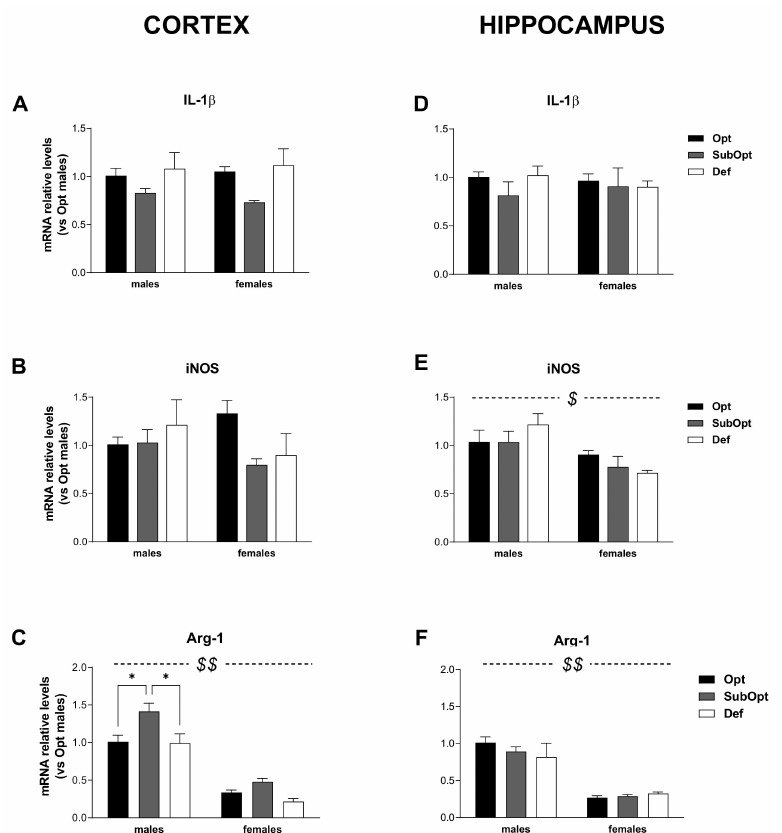
Figure 4. Effects of different Se supply on the level of IL-1 β , iNOS, and Arg-1 mRNA in the offspring’s cortex and hippocampus, evaluated by real-time PCR. The relative expression level of each mRNA was calculated using the 2 − ∆∆ Ct method, normalized to β -actin, and relative to the control group (i.e., male rats of the Opt Se dietary group). Each bar represents the mean ± SEM ( n = 5M, 5F). Cortex ( A – C ) $$ p < 0.0001 females vs. males (Arg-1: p = 0.001 for Se Opt females vs. Se Opt males; p < 0.0001 for either Se SubOpt or Se Def females vs. Se SubOpt or Se Def males, Tukey’s post hoc test). * p < 0.05. Hippocampus ( D – F ) $ p < 0.005 and $$ p < 0.0001 for females vs. males (iNOS: p < 0.05 for Se Def females vs. Def males; Arg-1: p < 0.0001 for Se Opt females vs. Opt males; p < 0.005 for either Se SubOpt or Se Def females vs. Se SubOpt or Se Def males, Tukey’s post hoc test). IL-1 β , interleukin-1 β ; iNOS, inducible nitric oxide synthase; Arg-1,